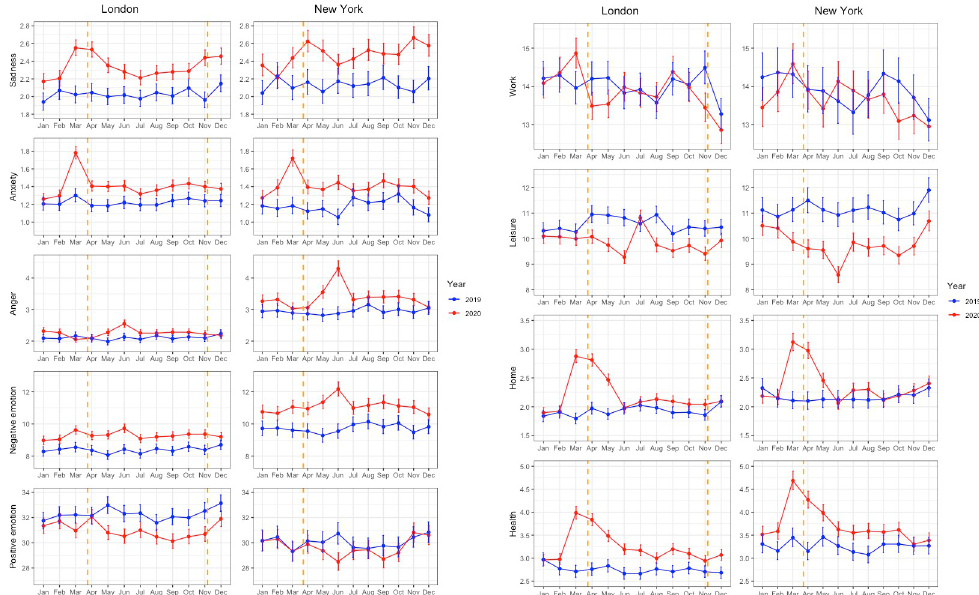
Fig 2. a Estimated monthly means of in-category word count for each LIWC category for an average user. Note . Orange dotted lines show the beginnings of the first (London and New York) and second (London only) lockdown. Estimates are based on mixed negative binomial regression models. The natural log of total word count was fixed to each city’s 2020 mean. Error bars denote 95% confidence intervals. b Estimated monthly means of in-category word count for each LIWC category for an average user. Note . Orange dotted lines show the beginnings of the first (London and New York) and second (London only) lockdown. Estimates are based on mixed negative binomial regression models. The natural log of total word count was fixed to each city’s 2020 mean. Error bars denote 95% confidence